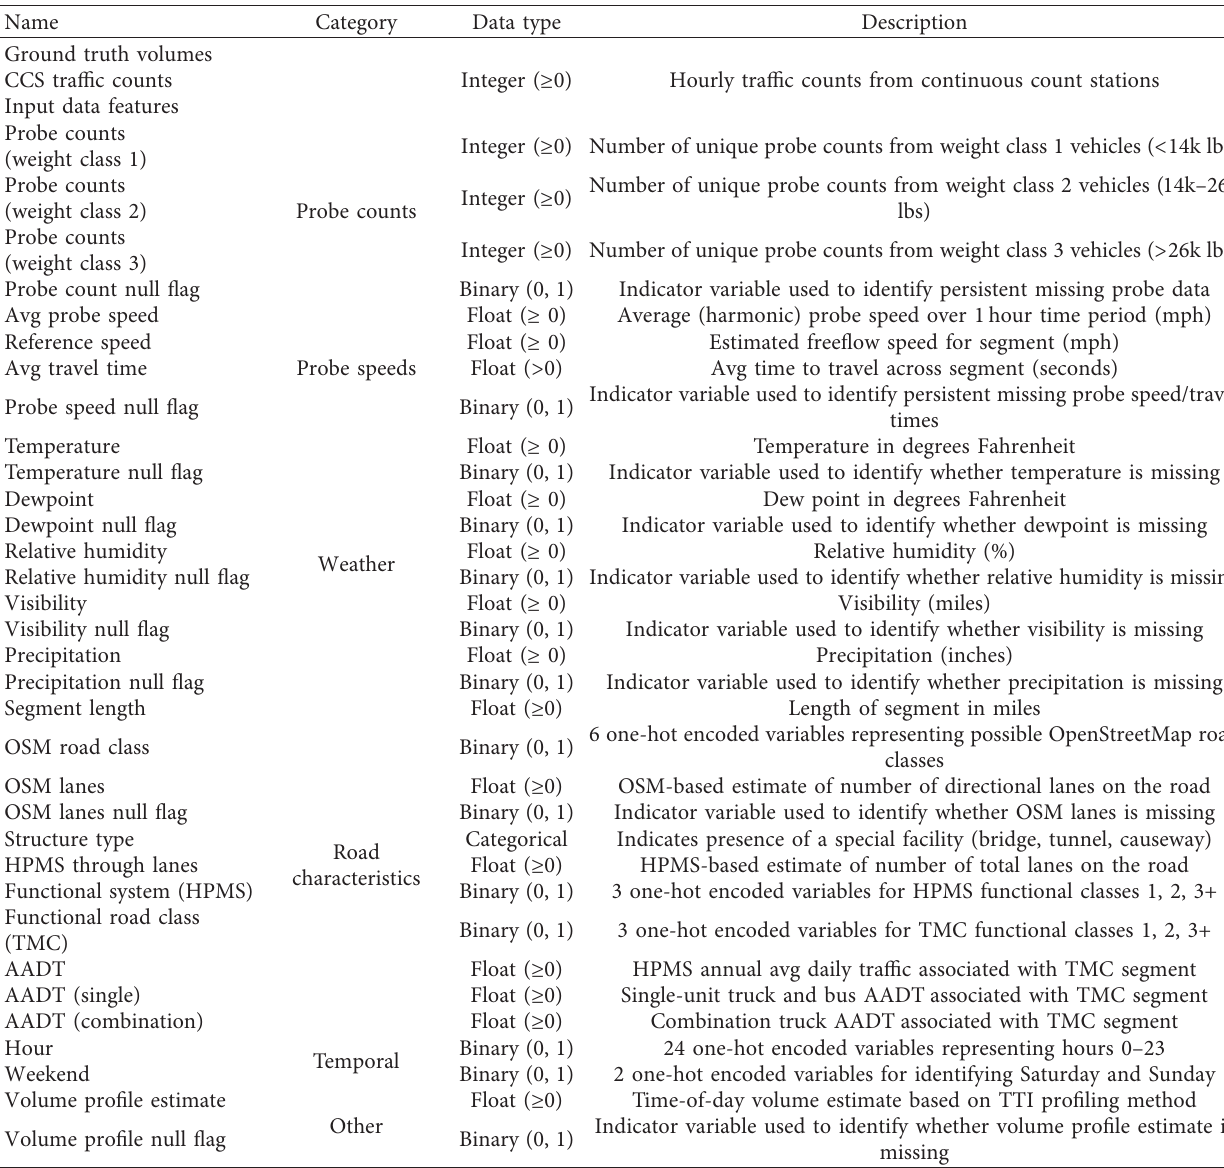
Table 1: Ground truth and input variables used for model